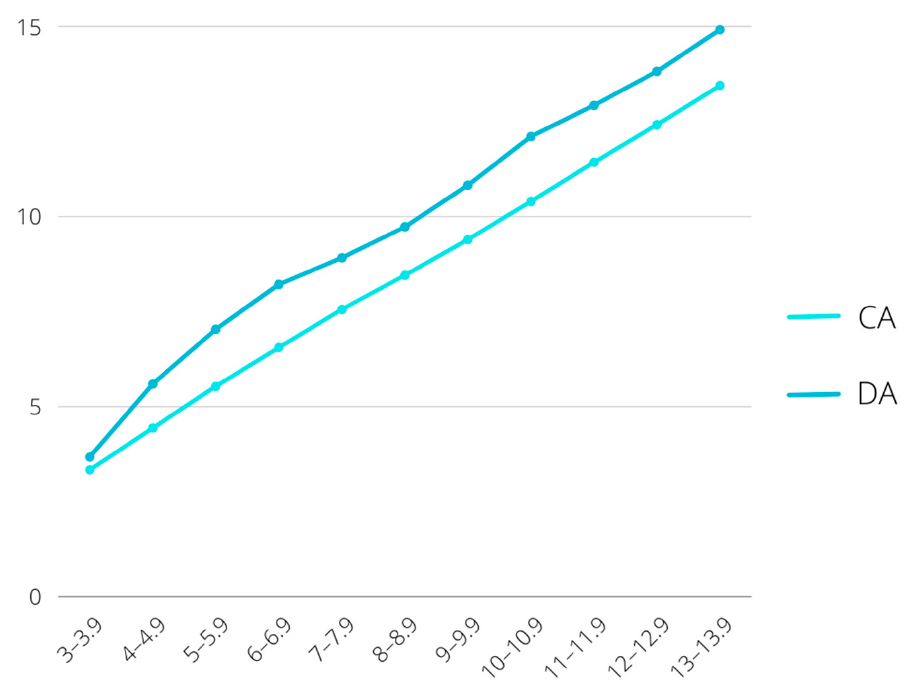
Figure 2. Chronological age (CA) and dental age (DA) in different age groups. Table 3. Comparison of the differences between chronological age and dental age according to the gender of the patients.